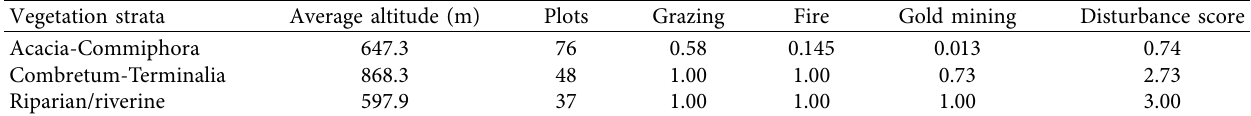
Table 1: Human disturbance variables (mean value) along the vegetation sites (strata).